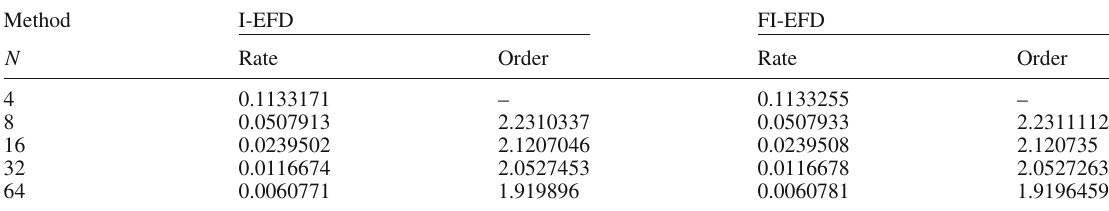
Table 10 Rate and order of convergence for T = 4 ,(cid:2) t = 10 − 4 , and (cid:2) x changes, Example 5.1